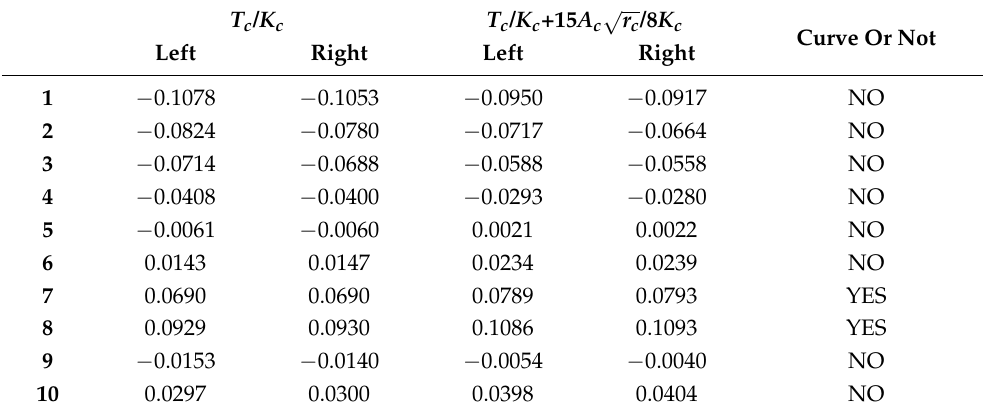
Table 2. Characteristic Parameters of Crack